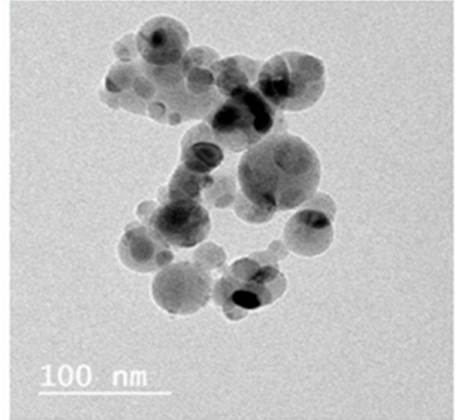
Figure 1. Transmission electron microscope images of TiSiO 4